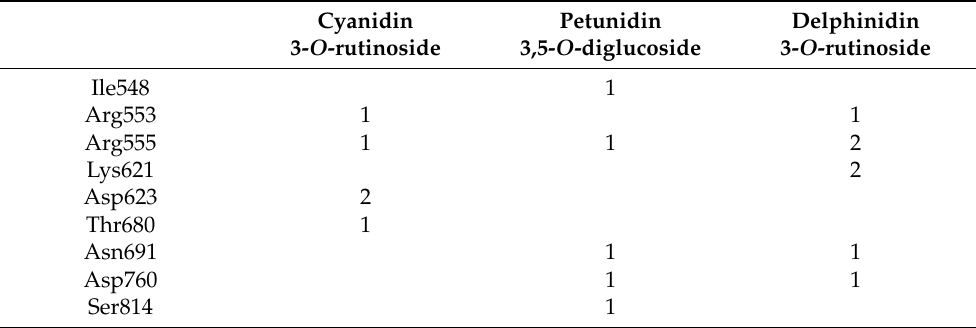
Table 2. The number of hydrogen bonds formed between the top three polyphenols and essential residues of SARS-CoV-2 RdRp.